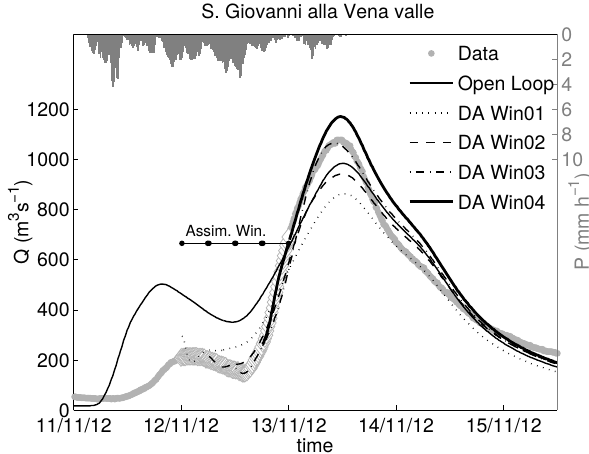
Figure 4. Hydrographs at S. Giovanni alla Vena measurement sta- tion for the flood event of 13 November 2012. Lines, symbols and acronyms maintain the same meaning of Fig.